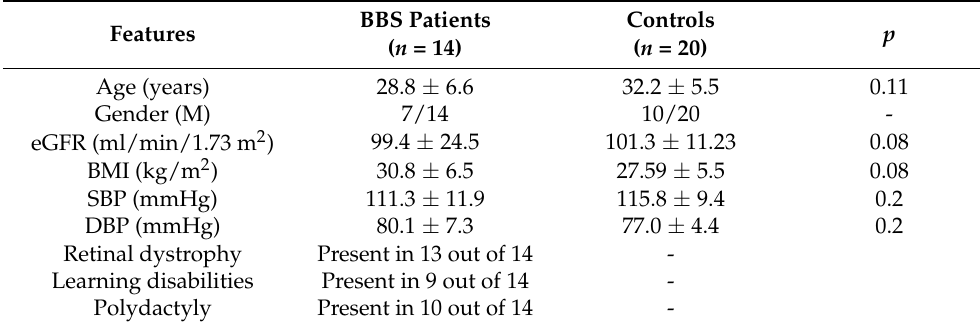
Table 1. Main features of BBS patients and controls: the pilot